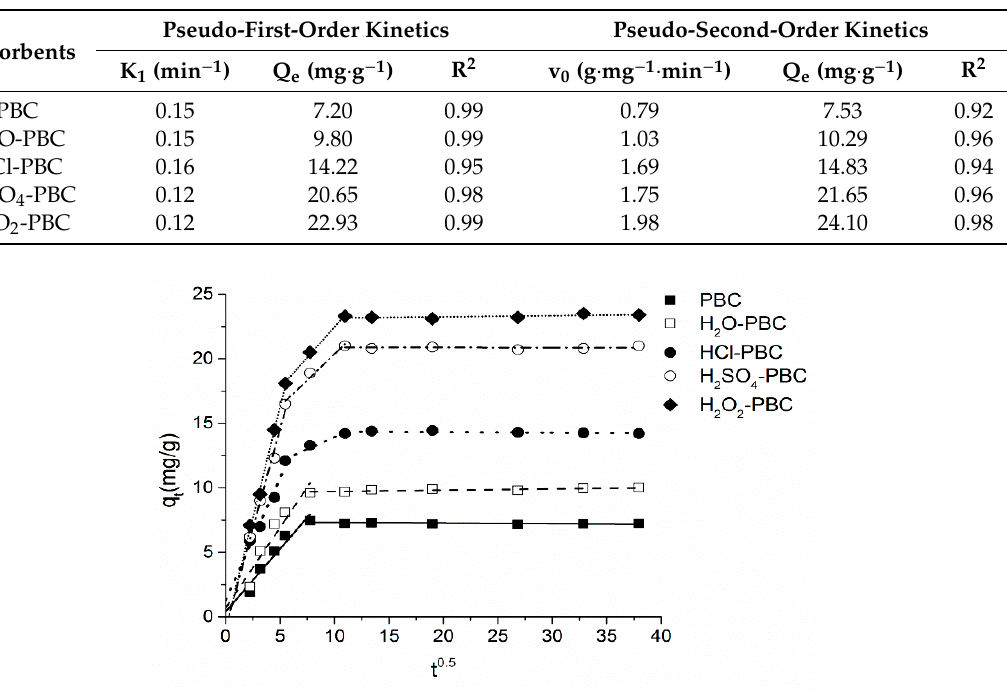
Figure 8. Adsorption kinetics of NH 4 + -N on the biochar samples as well as modeling through the intraparticle diffusion model (t is the adsorption time).